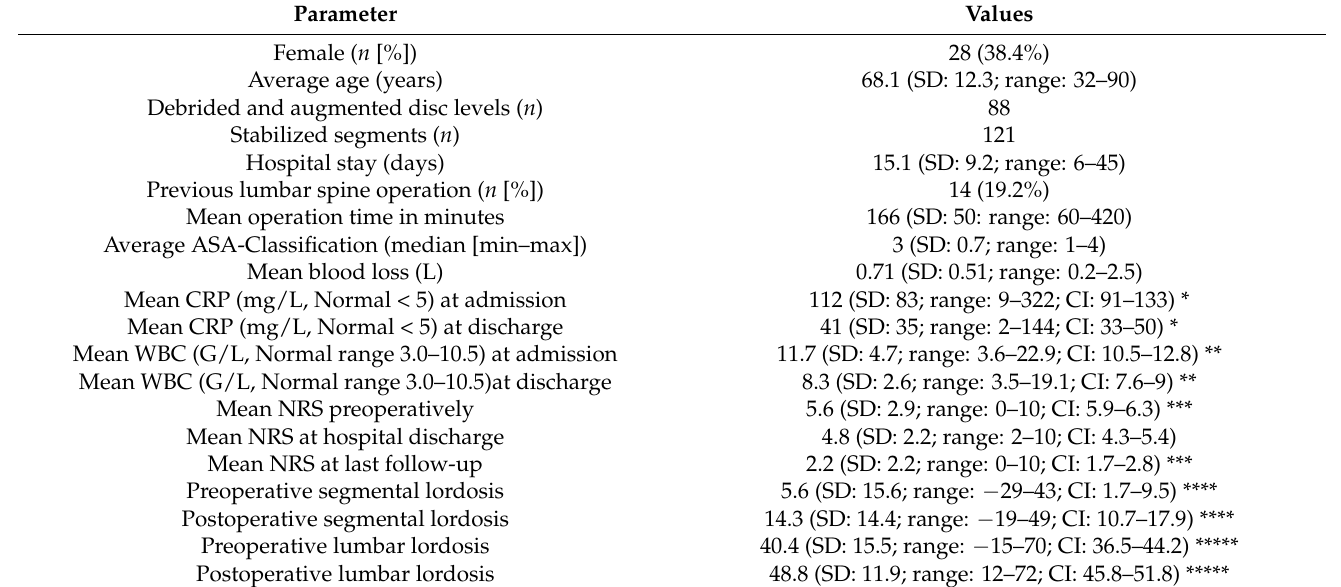
Table 1. Basic demographic data. (*), (**), (***), (****) and (*****) paired Student’s t -test p < 0.0001; NRS : Number Rating Scale for subjective evaluation of pain level (0–10); Segmental lordosis: Angle between the upper and lower endplate of the adjacent vertebra to the infected disc space and endplates. Lumbar lordosis: Angle between the upper endplate of vertebra Lumbar 1 and Sacral 1.